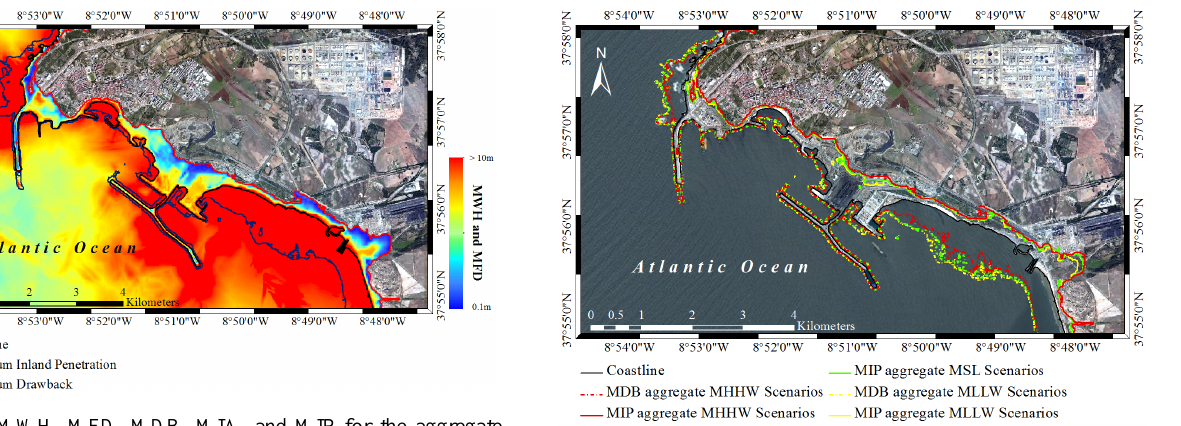
Figure 6. MWH, MFD, MDB, MIA, and MIP for the aggregate scenario considering all stages of the tide. MWH offshore and MFD on land are represented by the colour bar. MDB is indicated by the thick dark blue line. The MIA is given between the coastline (black line) and the MIP (red line).